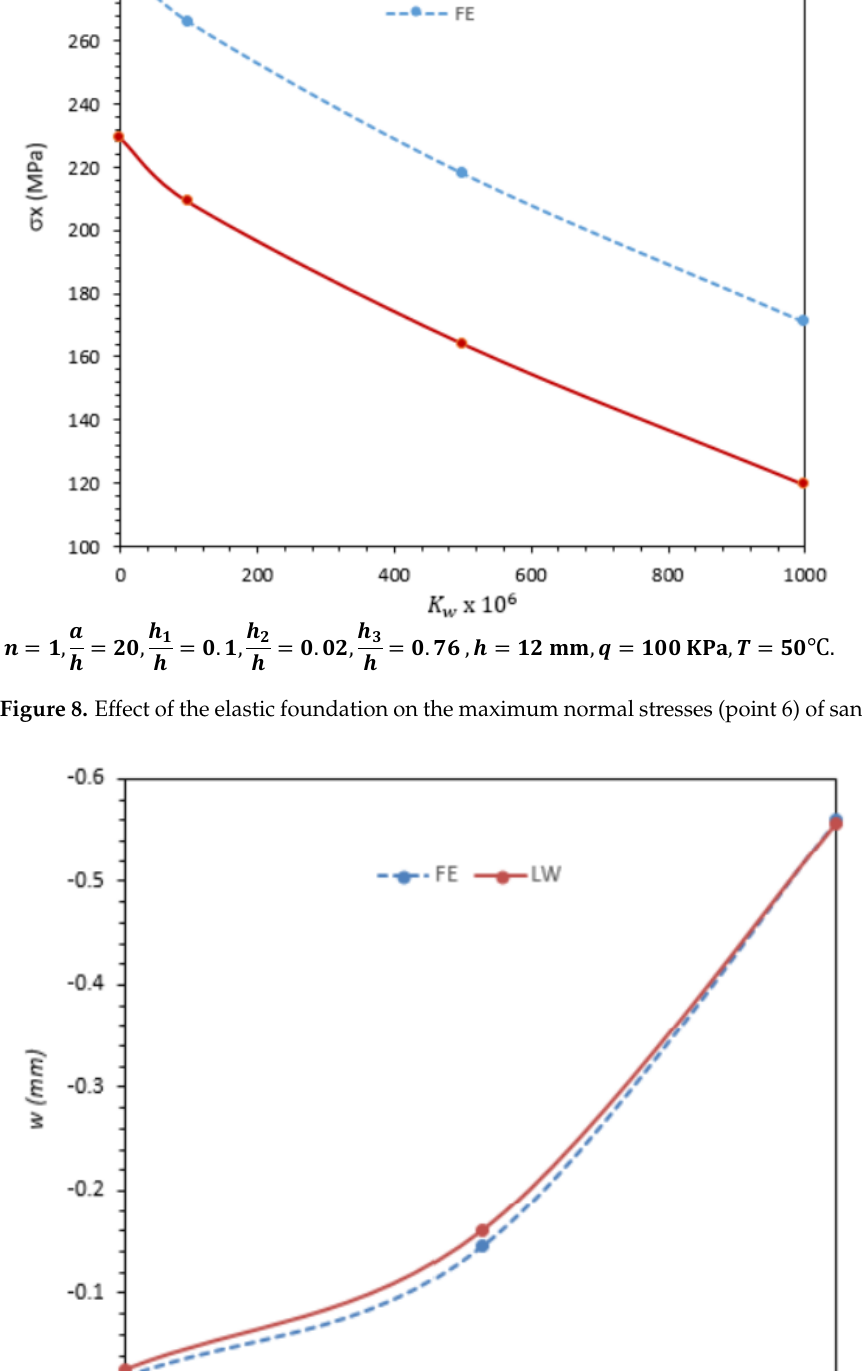
Figure 7. Effect of the elastic foundation on the center deflection of sandwich plate.